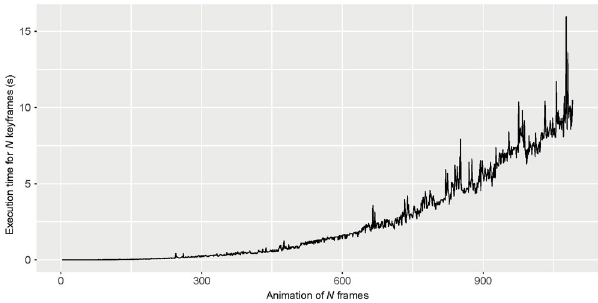
Fig. 14 Time required to build the all pairs table for each of the 20 mocap examples, when executed on a NVIDIA GeForce GTX 1080. The horizontal axis gives the size of the animation, in frames. The vertical axis gives execution time, in seconds.